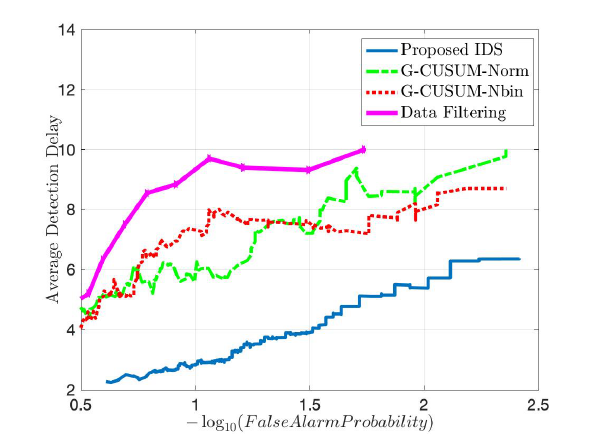
Figure 11. Comparison in terms of quick and accurate detection for an average DDoS attack magni- tude of 0.3 times the nominal mean data rate between the proposed method, two idealized G-CUSUM variants that know the exact attack magnitude, and the data filtering method.